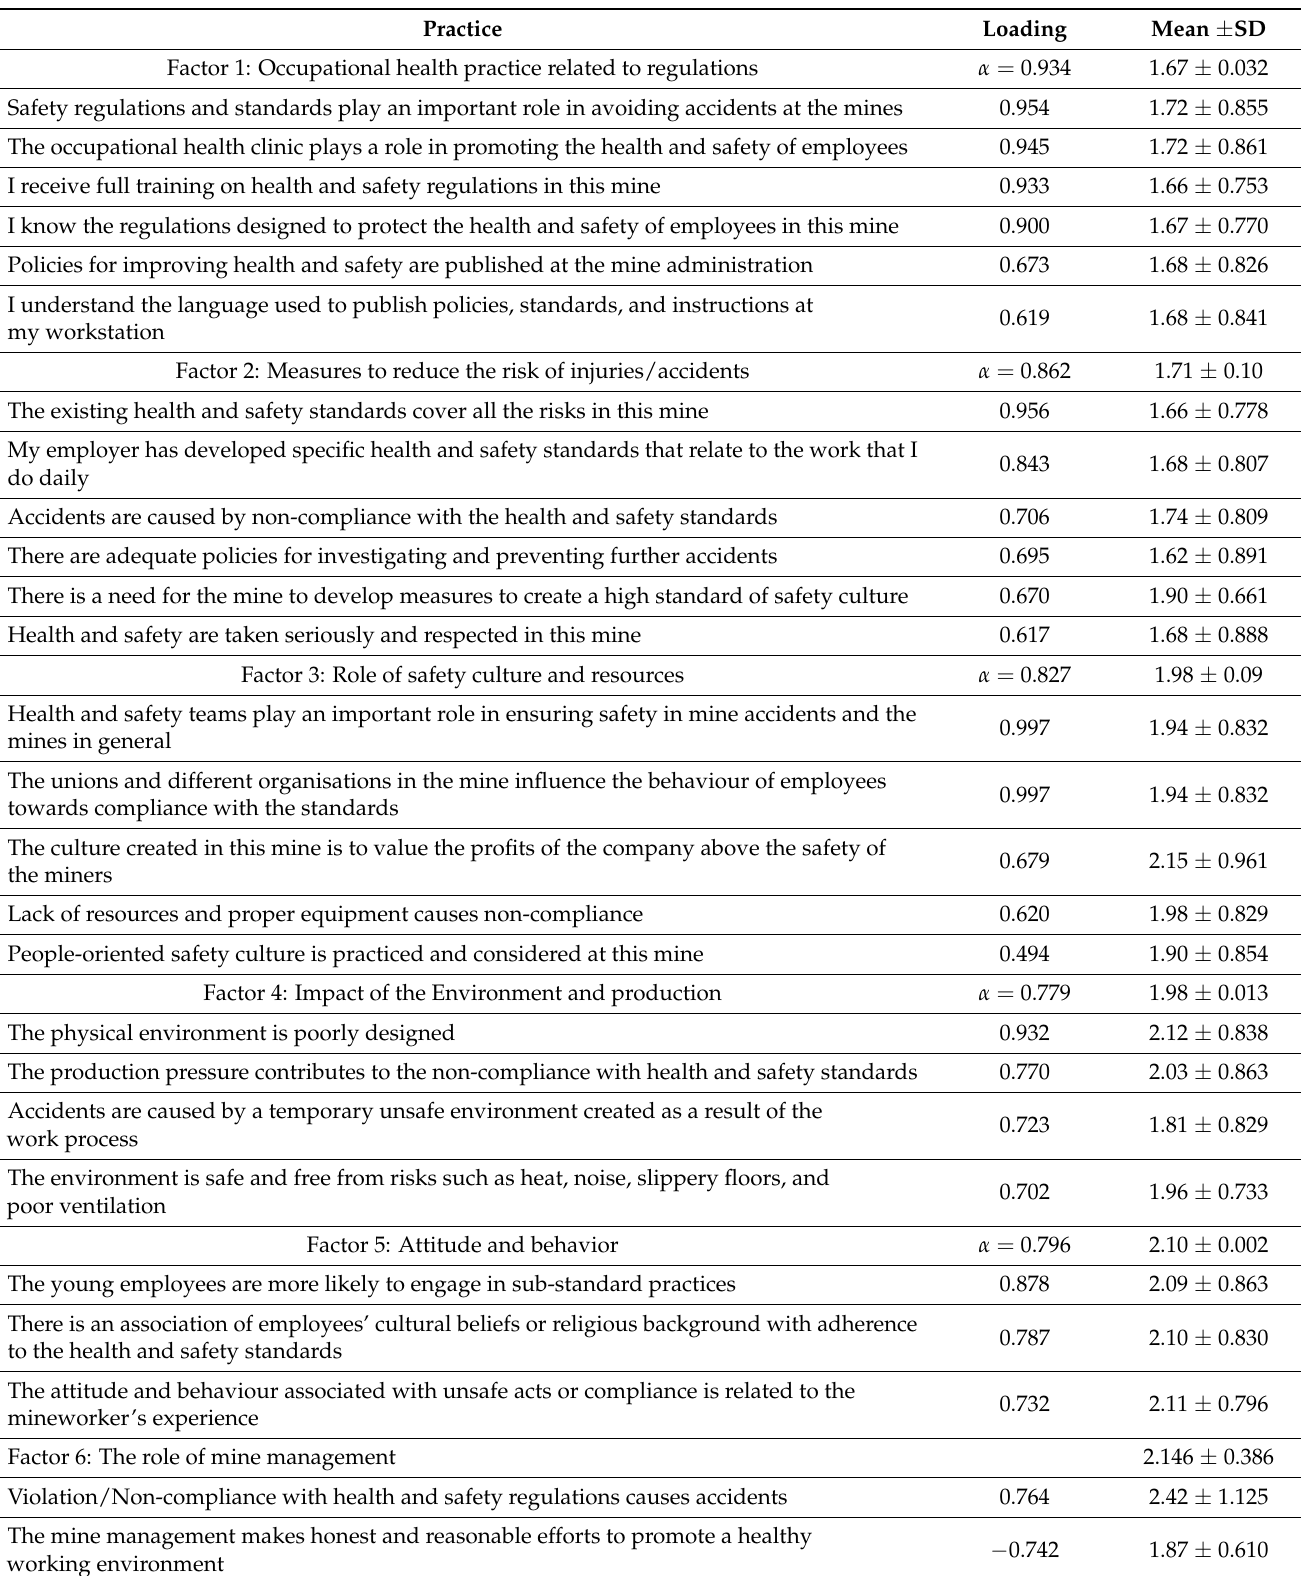
Table 2. Measurement model results for occupational health and safety standards compliance in a selected mine, Limpopo